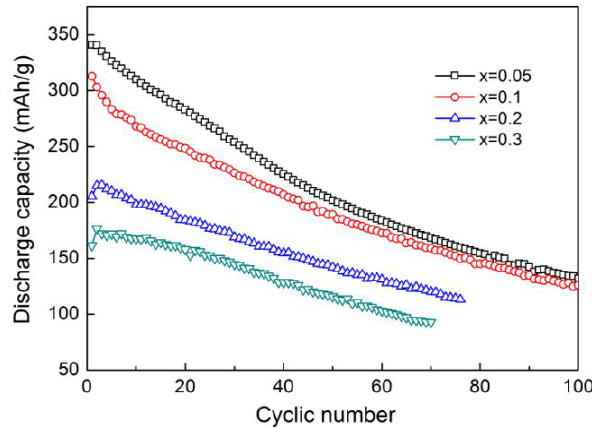
Figure 3. Cyclic life curves of La